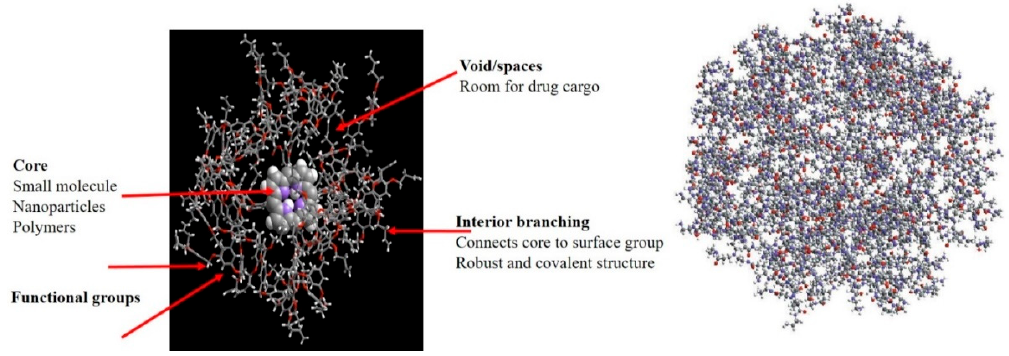
Figure 7. Schematic representation of dendrimers.